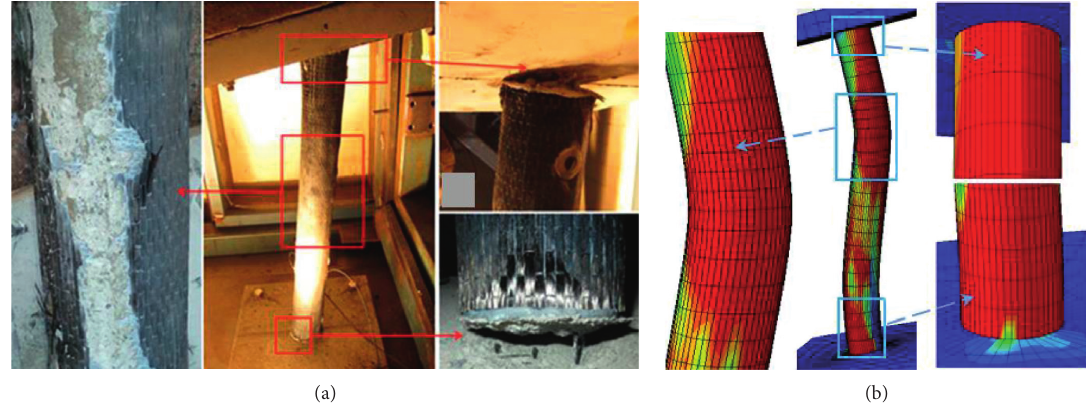
Figure 12: Comparison of damage modes at failure. (a) Experiment [3]. (b) Finite element.